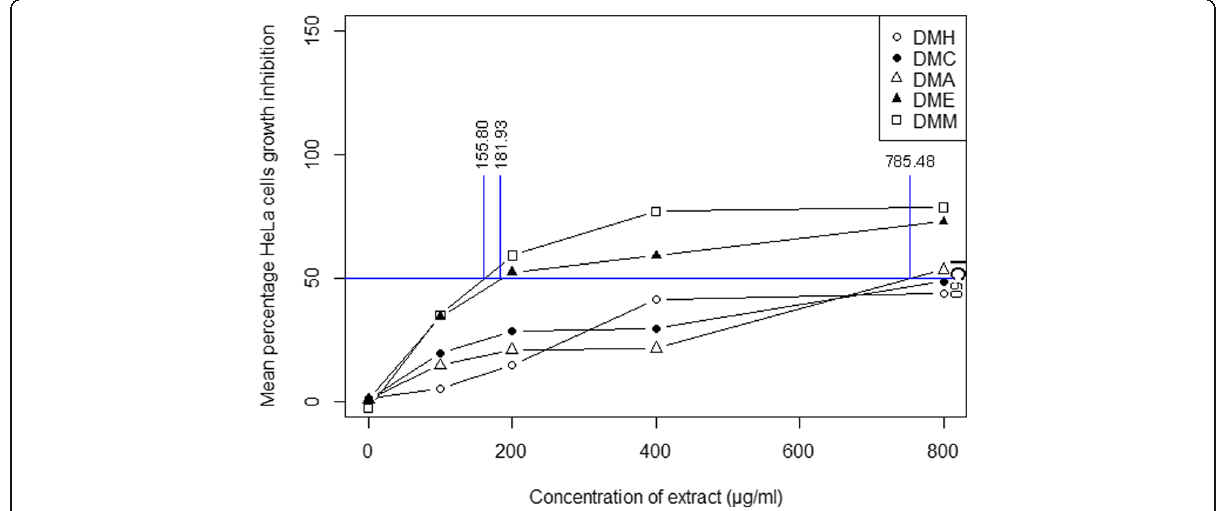
Fig. 3 Percentage of cell growth inhibition of the HeLa cell line by crude extracts of D. moniliforme and their cytotoxic capacities ( n = 3; p ≤